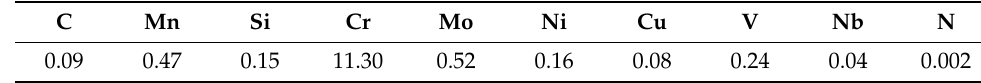
Table 1. Chemical composition of the Thor 115 steel, wt.%.